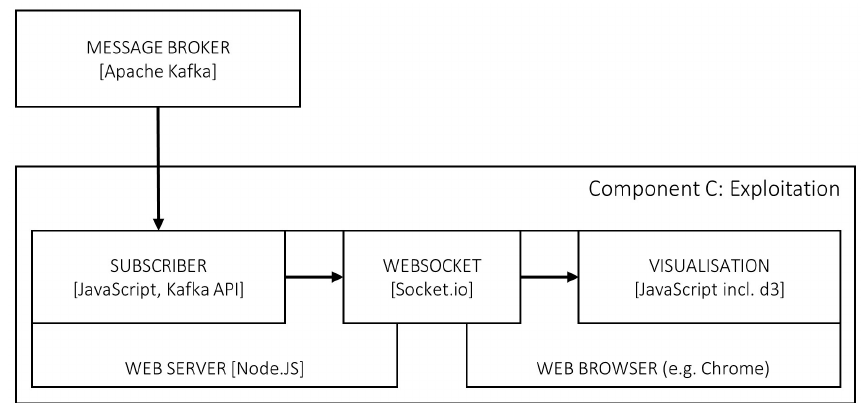
Figure 9. A depiction of the web ‐ based software system developed to exploit the integration and simulation system of Figure 1 for the case study.